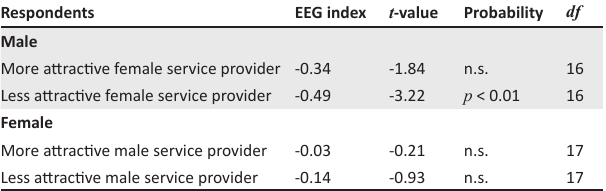
TABLE 2: Electroencephalography